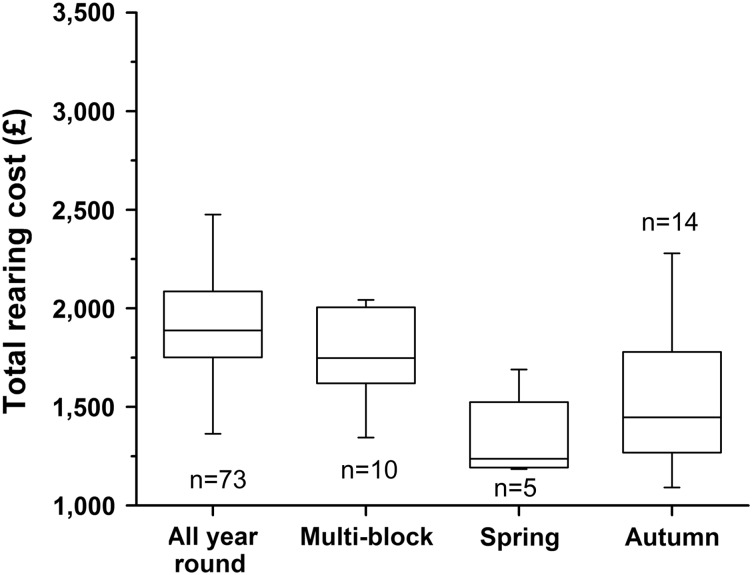
Box and whisker plot of minimum, maximum and median values of total rearing costs by calving pattern. All year round >autumn and spring, P<0.0001.